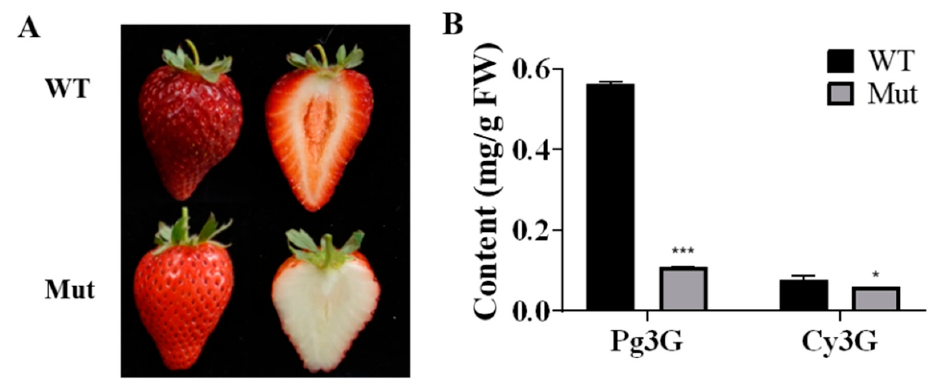
Figure 1. Phenotype ( A ) and anthocyanins content ( B ) analysis of ‘Sachinoka’ strawberry (WT) and its somaclonal mutant ‘Mixue’ ( Mut ) at red fruit stage. * ( p < 0.05) and *** ( p < 0.001) represent significant differences between ‘Sachinoka’ strawberry and its somaclonal mutant